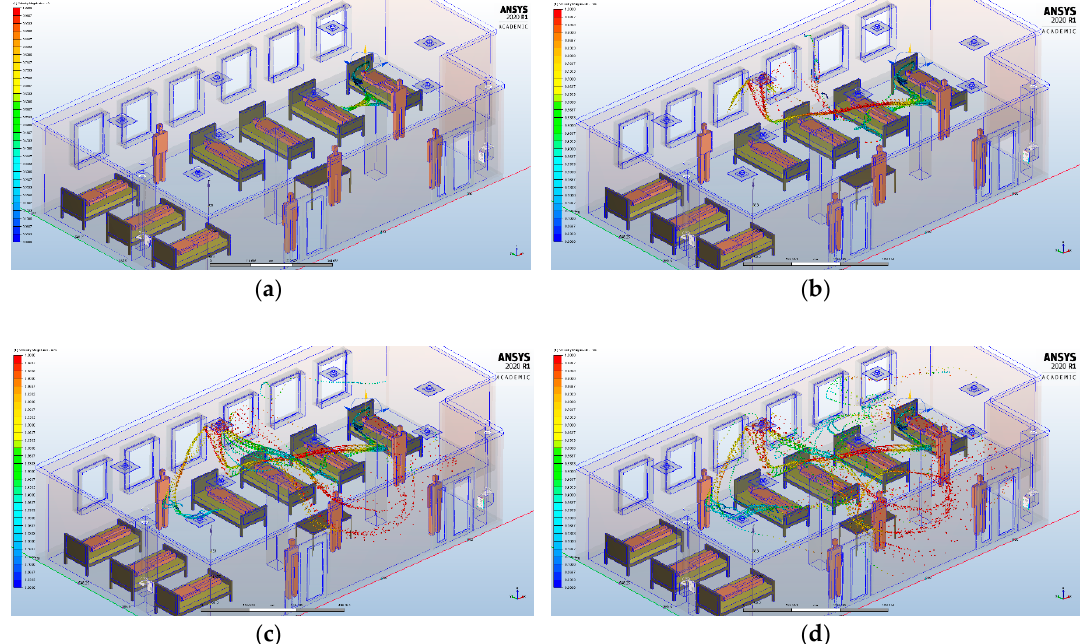
Figure 7. Transient analysis of the lighter particles dispersion carried into the air by buoyancy for HVAC systems, at different time intervals, if the infected patient is in the right part of the intensive care unit: ( a ) 2 s; ( b ) 3 s; ( c ) 4 s; ( d ) 5 s. unit: ( a ) 2 s; ( b ) 3 s; ( c ) 4 s; ( d ) 5